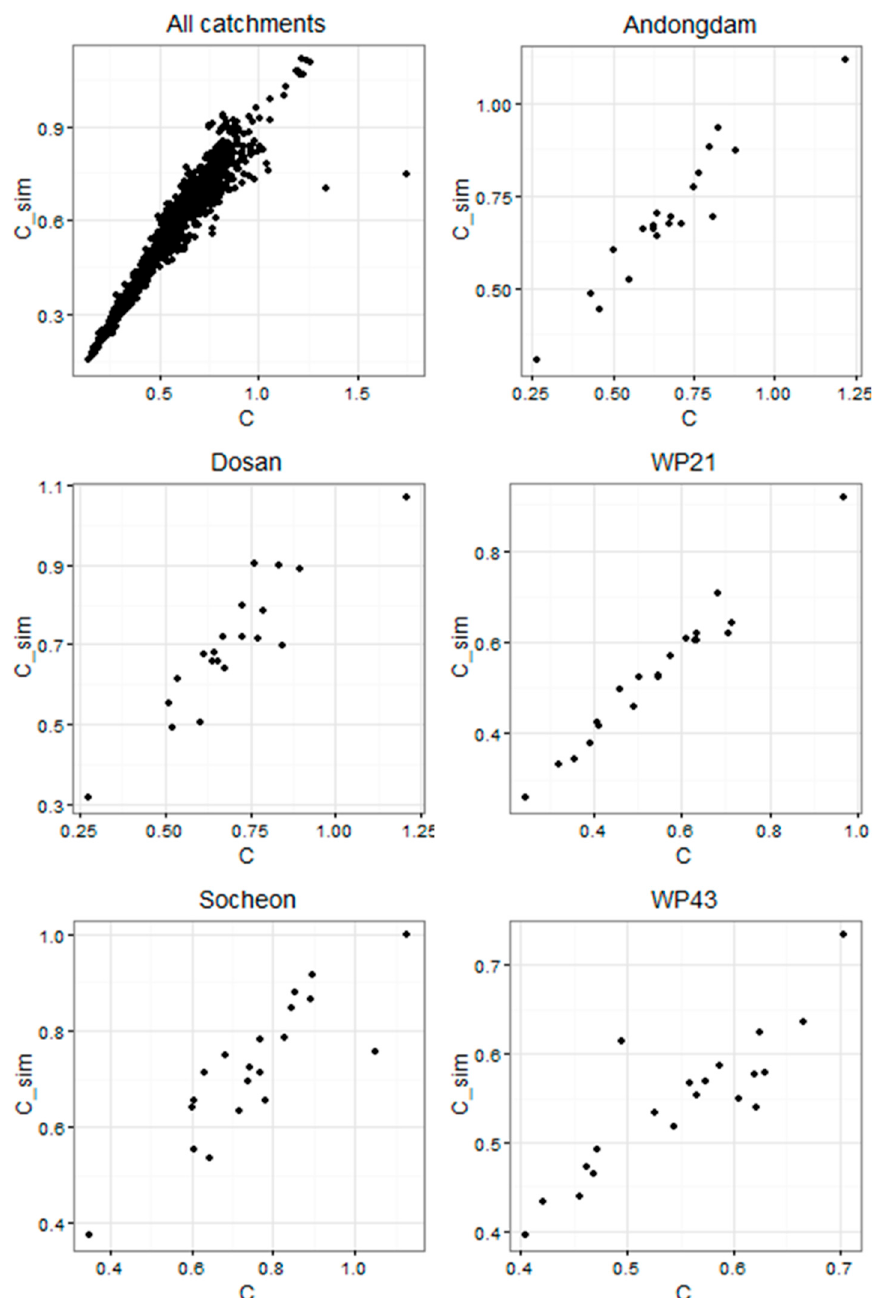
Figure 7. Comparison of the runoff coefficient ( C ) and the simulated runoff coefficient (C_sim), which are based on the relationship between C , C r , R 1, R 2, and CN.